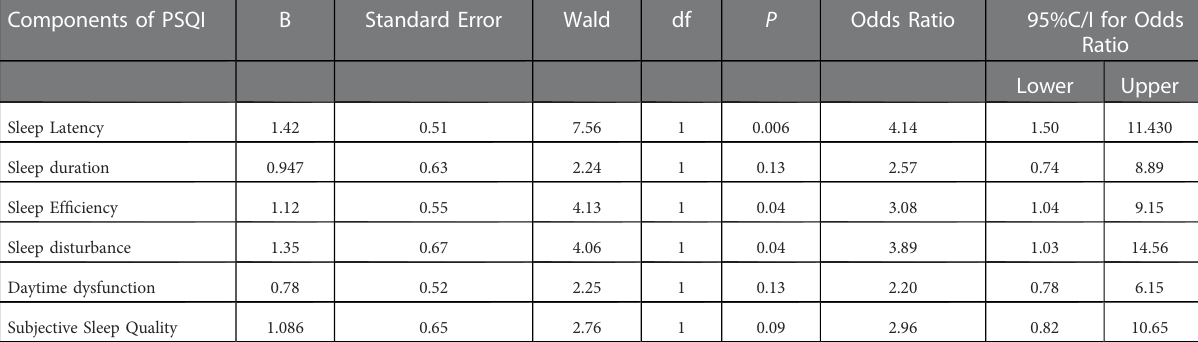
TABLE 3 Multivariate logistic regression model of sleep components of PSQI for increased carotid intima media thickness. Components of